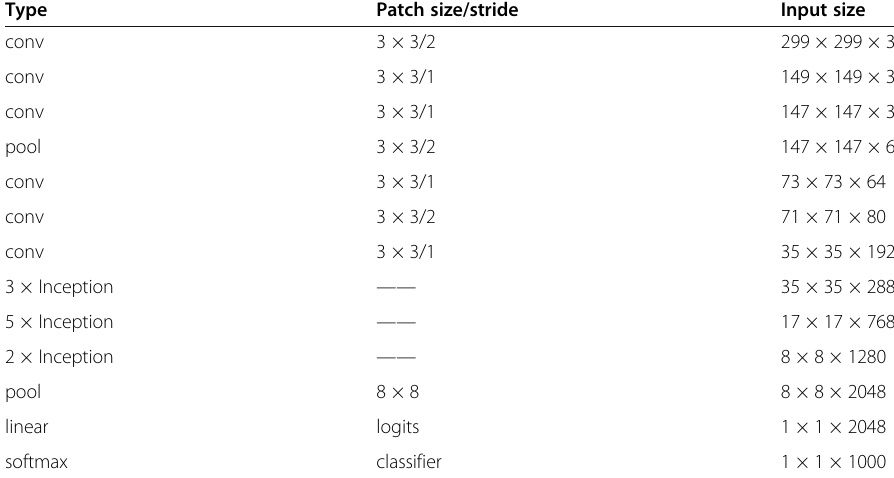
Table 1 Network structure of the Inception-v3 model